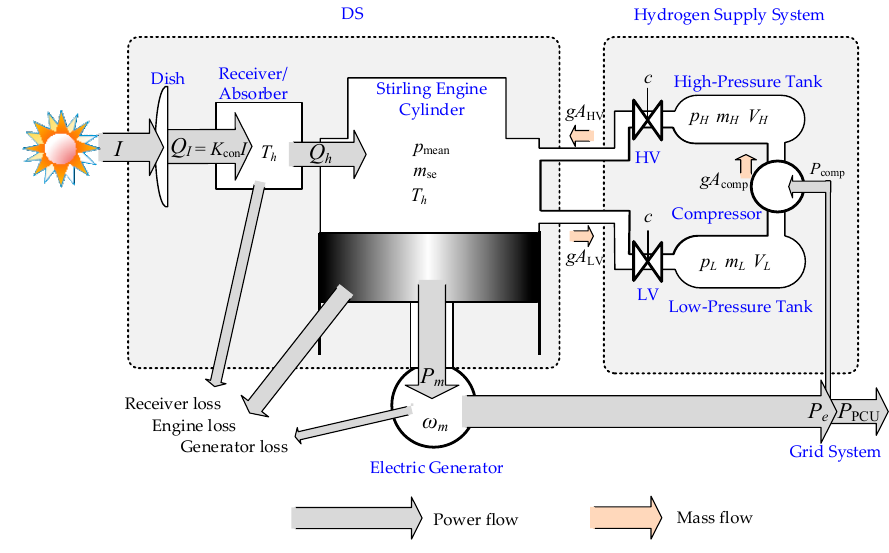
Figure 1. Schematic of dish/receiver-absorber, average-value single-cylinder equivalence to a double-acting kinematic Stirling engine, electric generator, and hydrogen supply system.